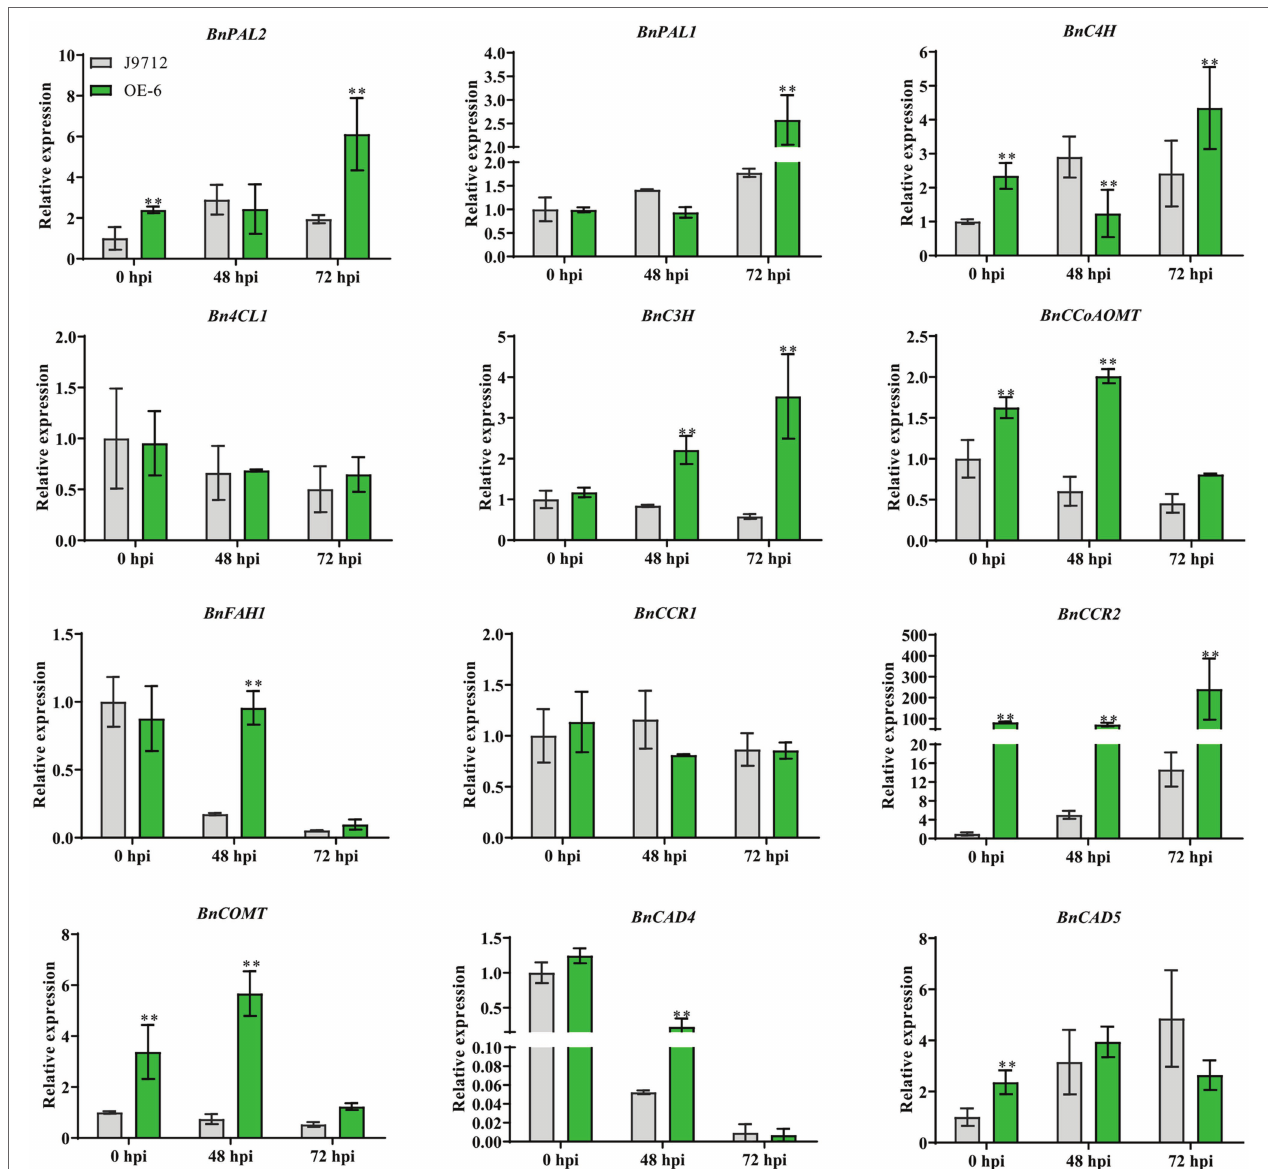
FIGURE 6 | Expression analysis of key genes involved in lignin biosynthesis under normal growth conditions (before inoculation) and S. sclerotiorum inoculation conditions (48 hpi and 72 hpi). The bars represent the standard deviations ( n = 3). * and ** indicate significant differences between OE-6 and J9712 ( * p < 0.05; * p < 0.01; and Student’s